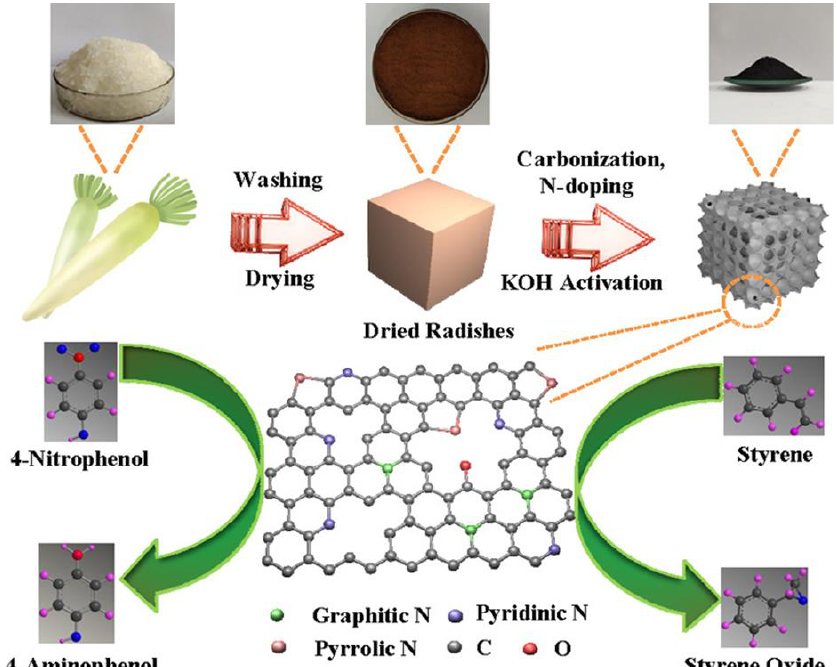
Figure 22. Schematic representation of the synthesis of N-doped porous carbon derived from cheap and abundant radish which was employed as an efficient bifunctional catalyst for the catalytic reduction of 4-Nitrophenol and oxidation of styrene. Adapted with permission from ref. [123].